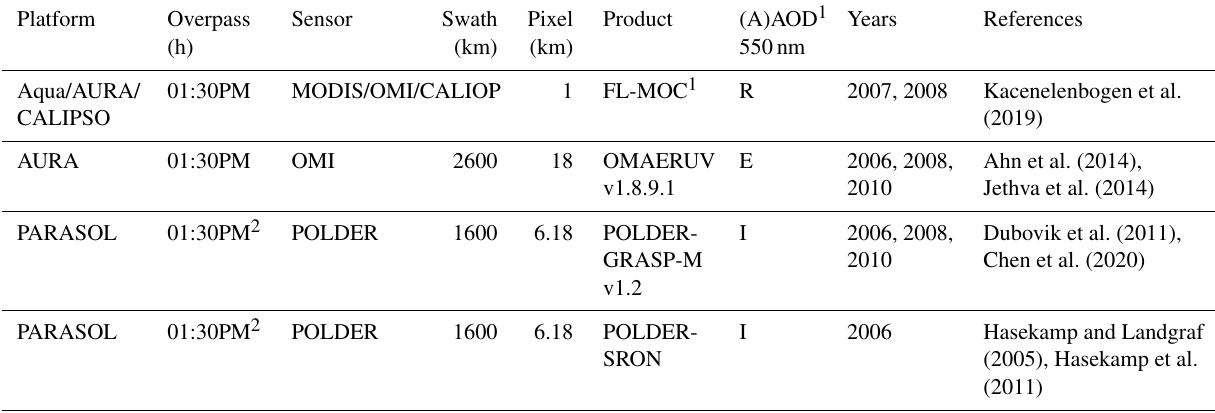
Table 1. Remote sensing products used in this study.